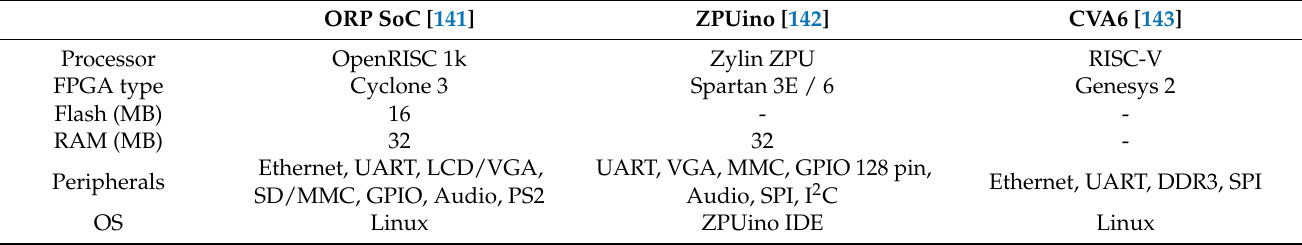
Table 7. SoCs that integrate a